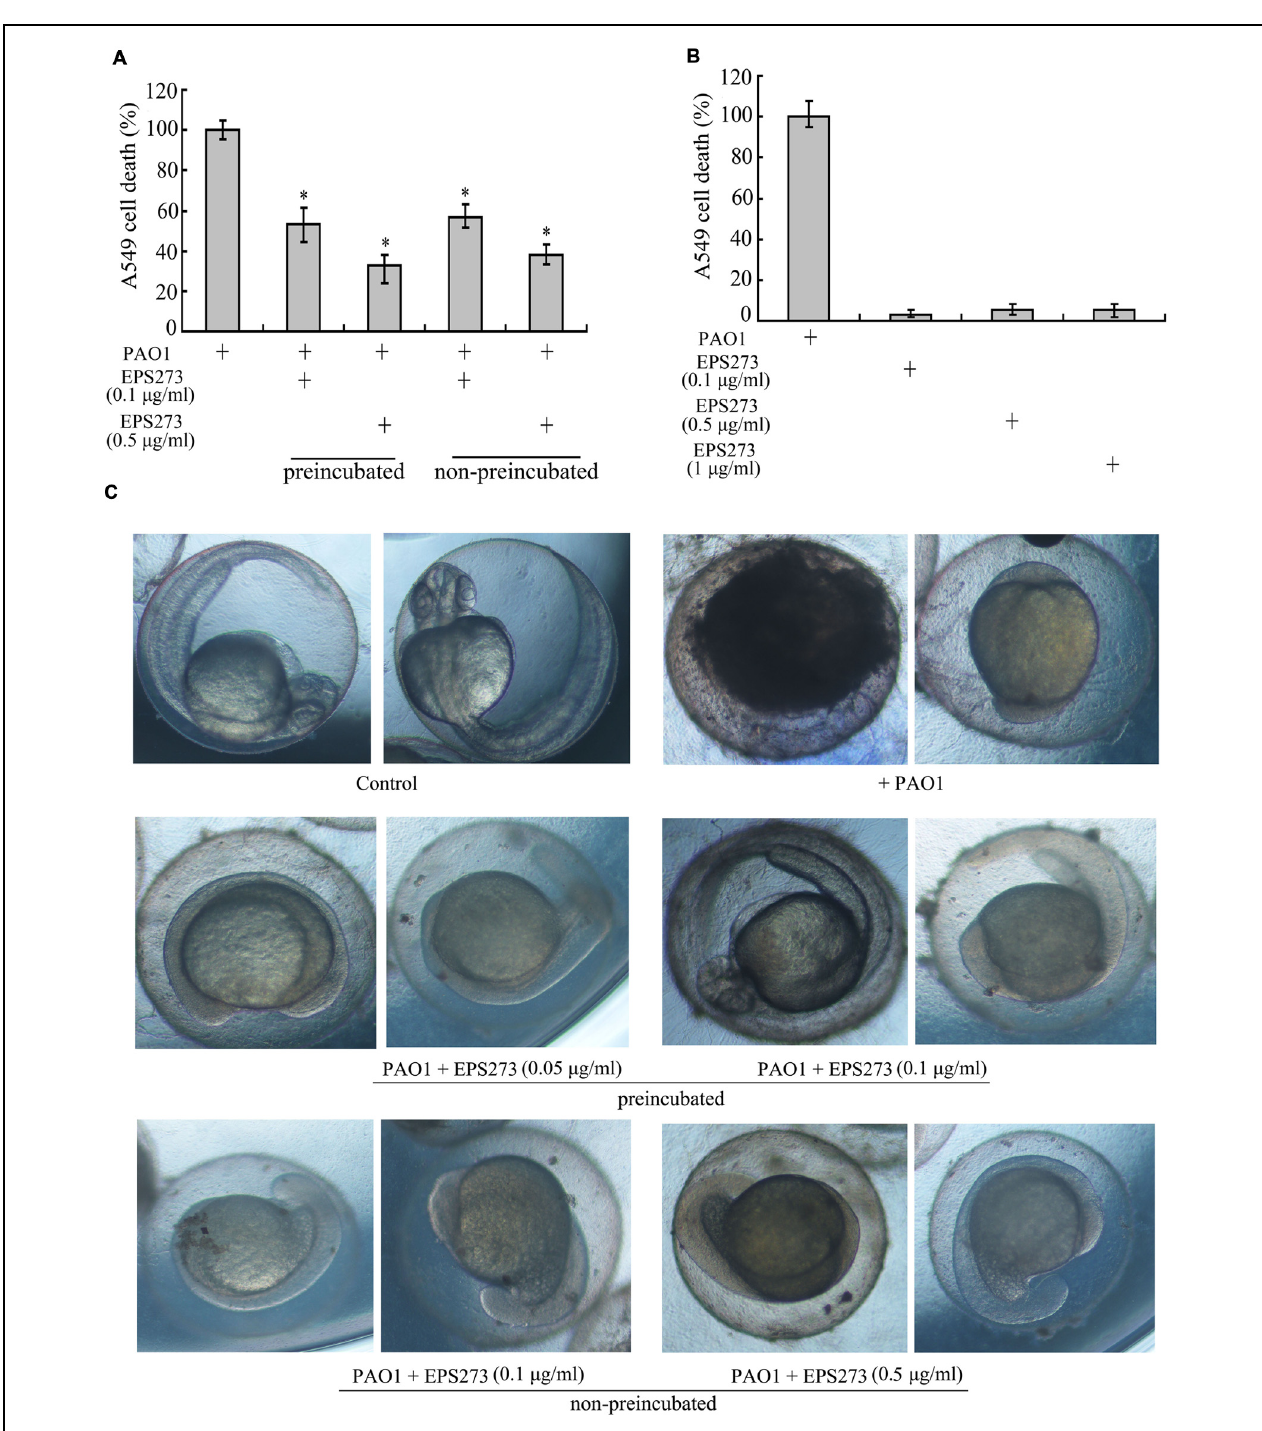
FIGURE 6 | Inhibition activities of EPS273 on P. aeruginosa PAO1 infection to human A549 lung cells and zebrafish embryos. (A) EPS273 inhibits P. aeruginosa PAO1 infection to human A549 lung cells. The percent cell death was calculated using propidium iodide uptake into A549 lung cells after 8 h and normalized to cells in the absence of EPS273, of which the cell death was set as 100%. Error bars indicate the standard deviations of three measurements. ∗ P < 0.05 versus the control. (B) The cytotoxic analysis of EPS273 to A549 human lung cells. A549 human lung cells were treated with 0.1, 0.5, and 1 µ g/mL of EPS273 in the absence of P. aeruginosa PAO1. The percent cell death was calculated using uptake into A549 lung cells after 8 h and normalized to lung cells treated with P. aeruginosa PAO1 in the absence of EPS273, of which the cell death was set as 100%. Error bars indicate the standard deviations of three measurements. ∗ P < 0.05 versus the control. (C) EPS273 inhibits P. aeruginosa PAO1 infection to zebrafish embryos. Zebrafish embryos were infected with P. aeruginosa PAO1 in the presence or absence of EPS273 and imaged after 24 h infection. All the pictures were taken with inverted microscope (Nikon TS100, Japan) at 40X.